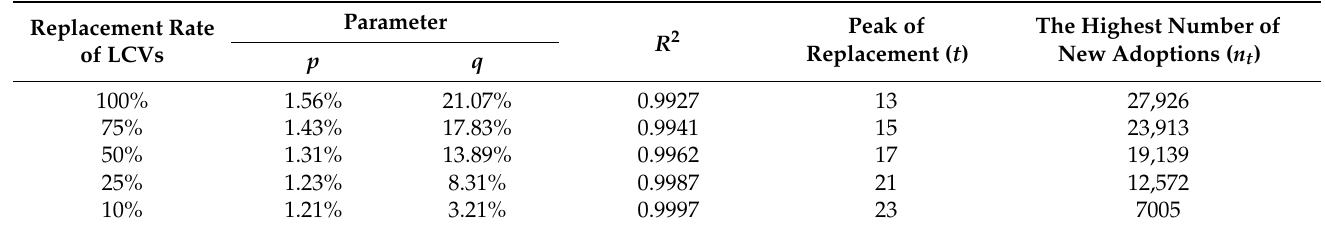
Table 4. Simulation results of full penetration for the scenarios in which light trucks are replaced by eLCVs with rates of 100%, 75%, 50%, 25% and 10%.